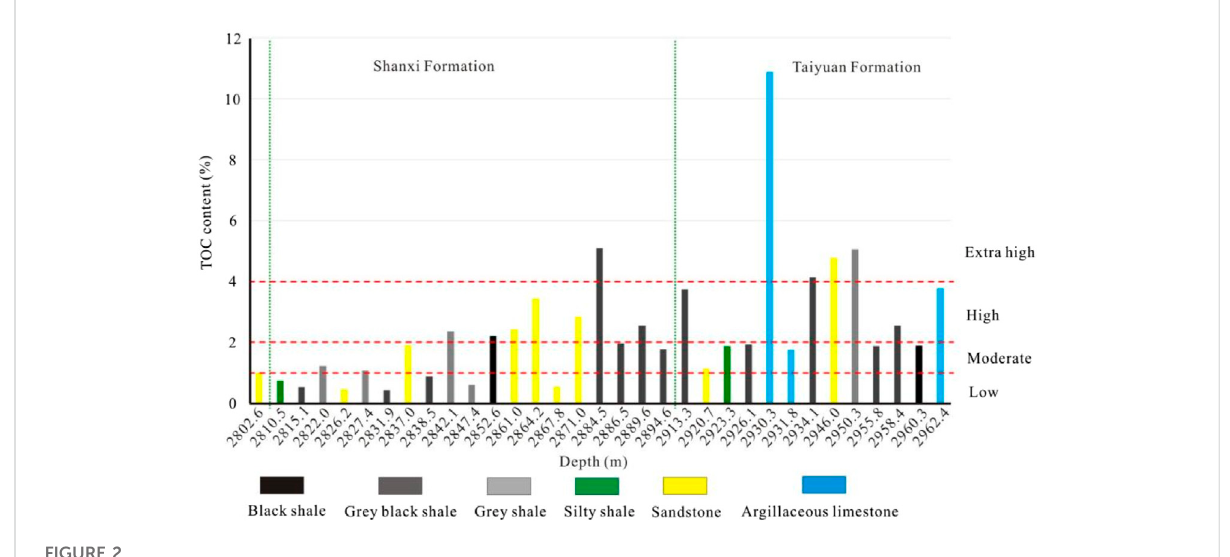
FIGURE 2 Total organic carbon content (TOC) distribution histograms for samples in well